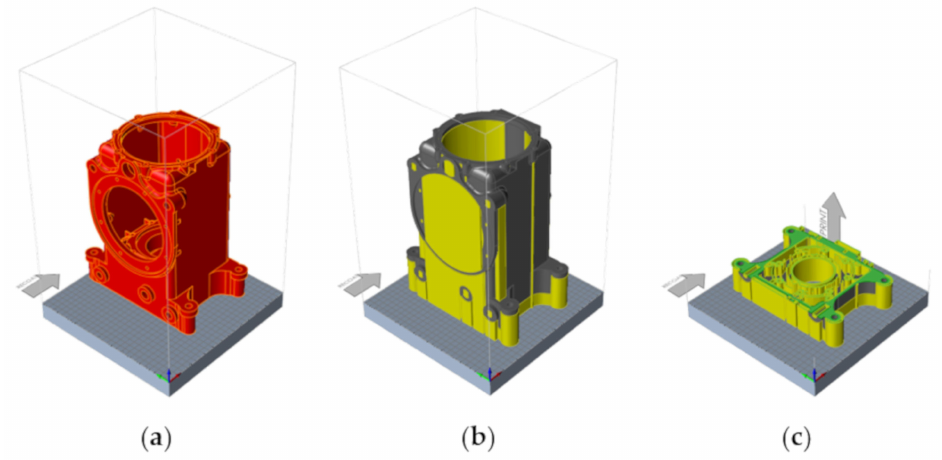
Figure 5. Stages of pre-processing: placing and orientation in chamber ( a ), support generation ( b ) and slicing ( c